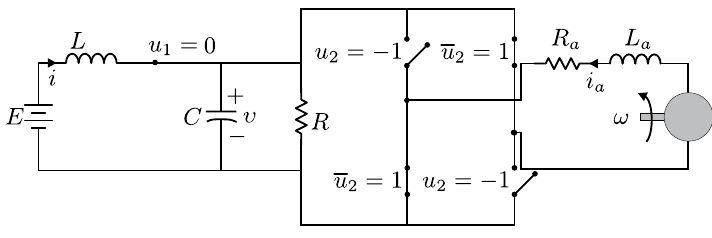
Figure 4. Equivalent circuit when u 1 = 0 and u 2 = − 1.